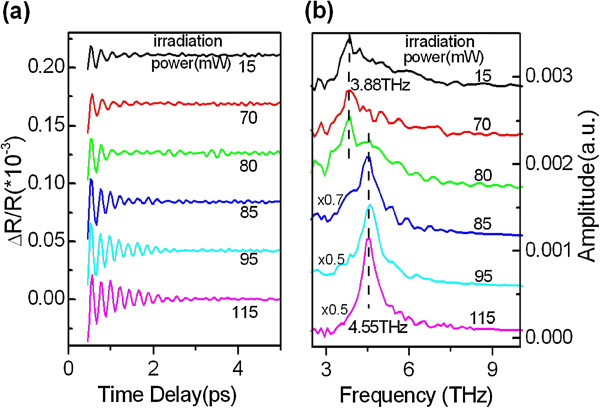
Transient COP oscillation of a single layer of 5-nm-thick Sb80Te20film (a).(b) FFT spectra corresponding to (a).